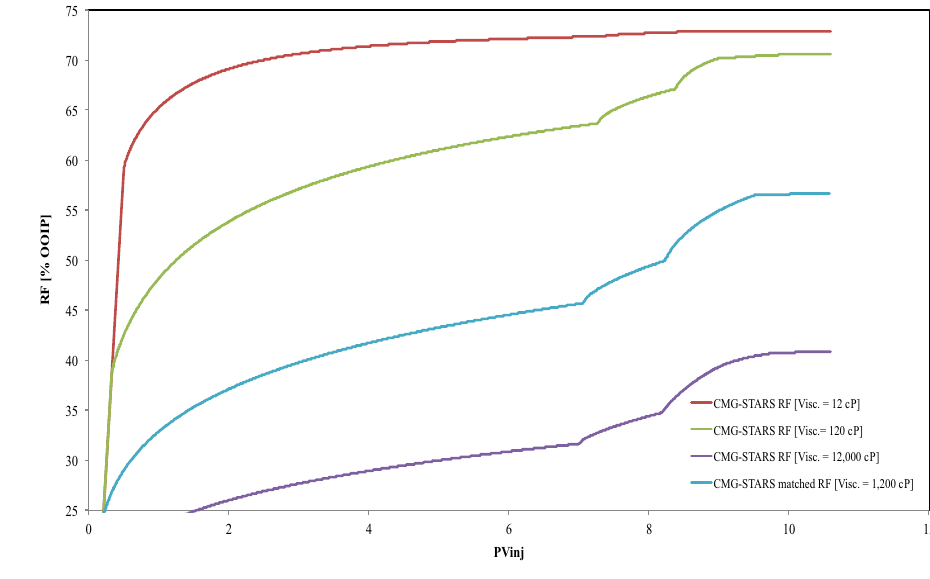
Fig. 17 The efficiency of chemical slug for different oil